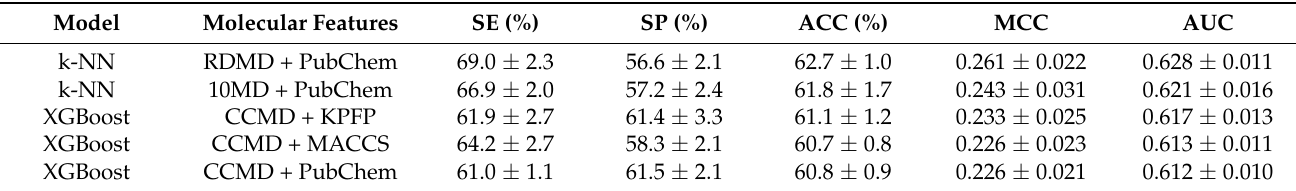
Table 2. The five-fold cross-validation results of the top-five classification models.